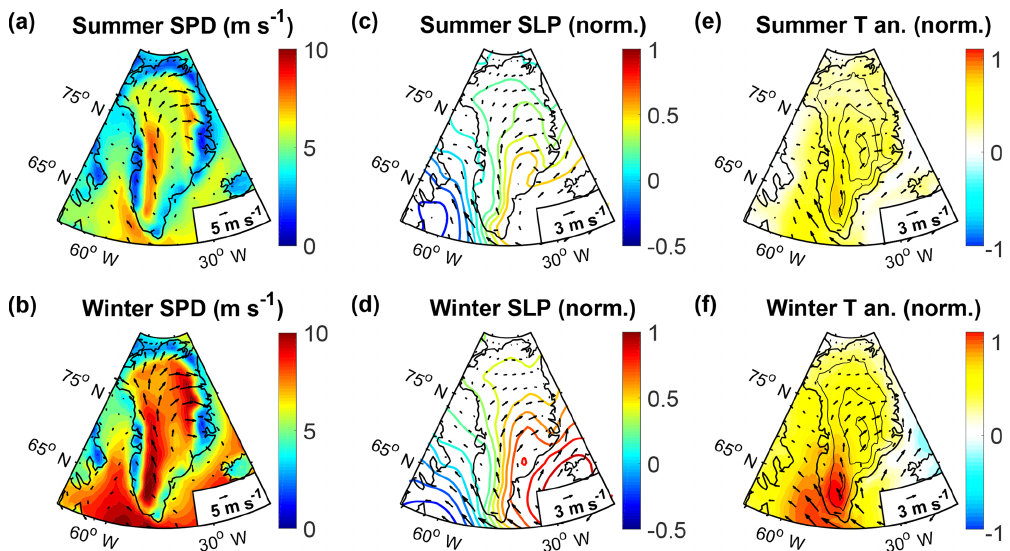
Figure 4. Composites of the (a, b) mean 10m surface winds and the normalized (c, d) sea level pressure and (e, f) temperature anomalies with the 10m surface wind anomalies during melt events in summer and winter, obtained from ERA-I. Normalized means that for each event the climatological monthly means have been subtracted and the result has been divided by the interannual standard deviation at each month.